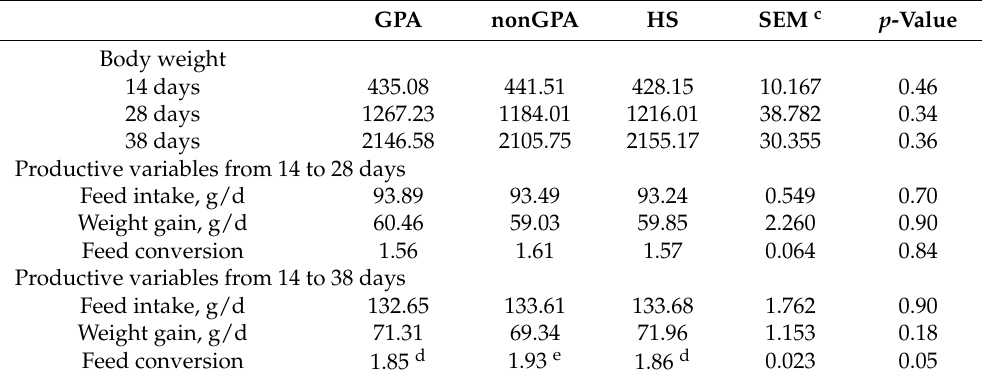
Table 2. Effect of the type of growth promoter on the productive performance from 14 to 38 days a,b .